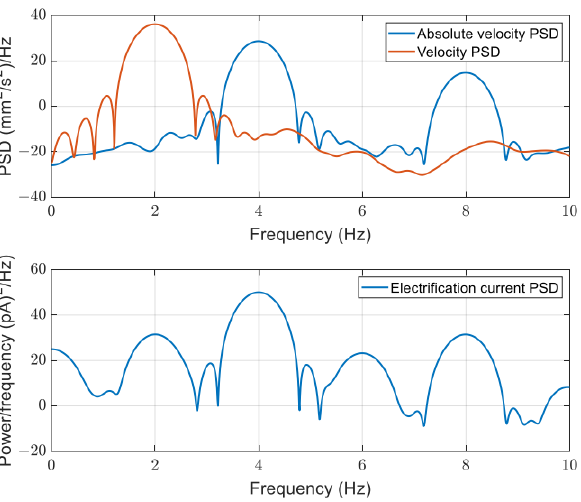
Figure 11. Power spectral densities estimated using Welch’s method of velocity and electrification current signals. The shuttle frequency is 2